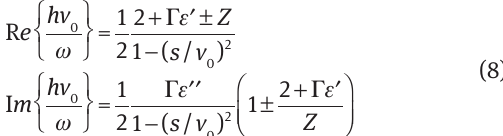
are the transverse wavenumbers for the spacer and for the substrate dielec- tric. One can easily see that dispersion equation of Equa- tion 5 simplifies to Equation 4 in the limit of negligible spacer and infinitely thick metal film; d = 0, Δ→ ∞